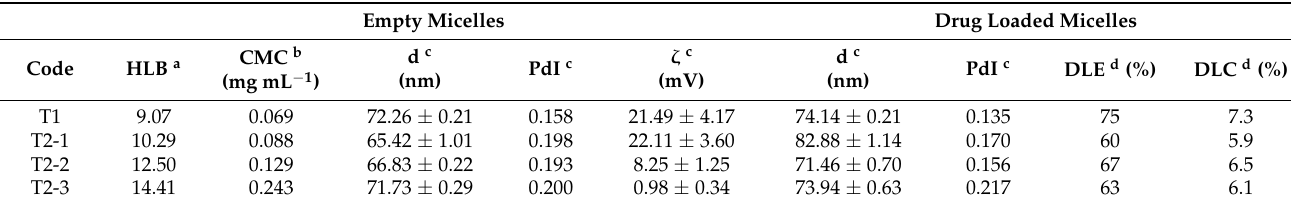
Table 2. Characteristics of triblock copolymer micelles before and after the drug loading. Empty Micelles Drug Loaded